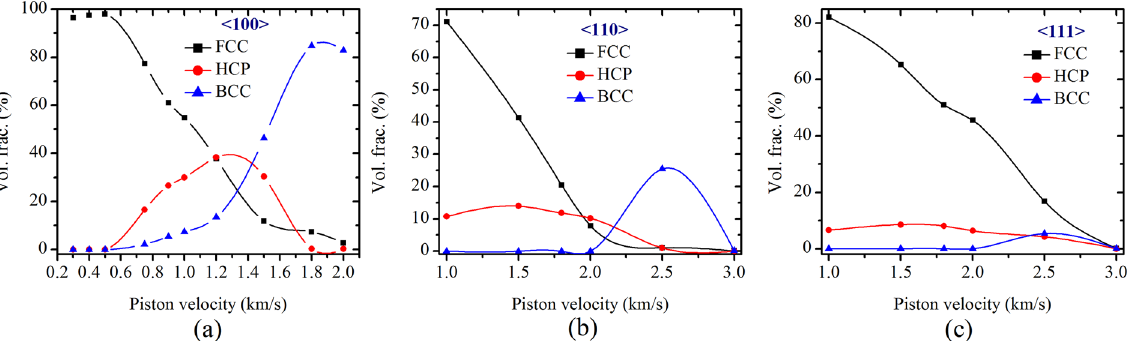
Figure 2. Evolution statistics of different nucleated phases like BCC, HCP from initial undeformed FCC phase of copper at a range of piston velocity from 0.8 km/s to 3.0 km/s for three crystallographic direction of ( a ) 〈 100 〉 ,